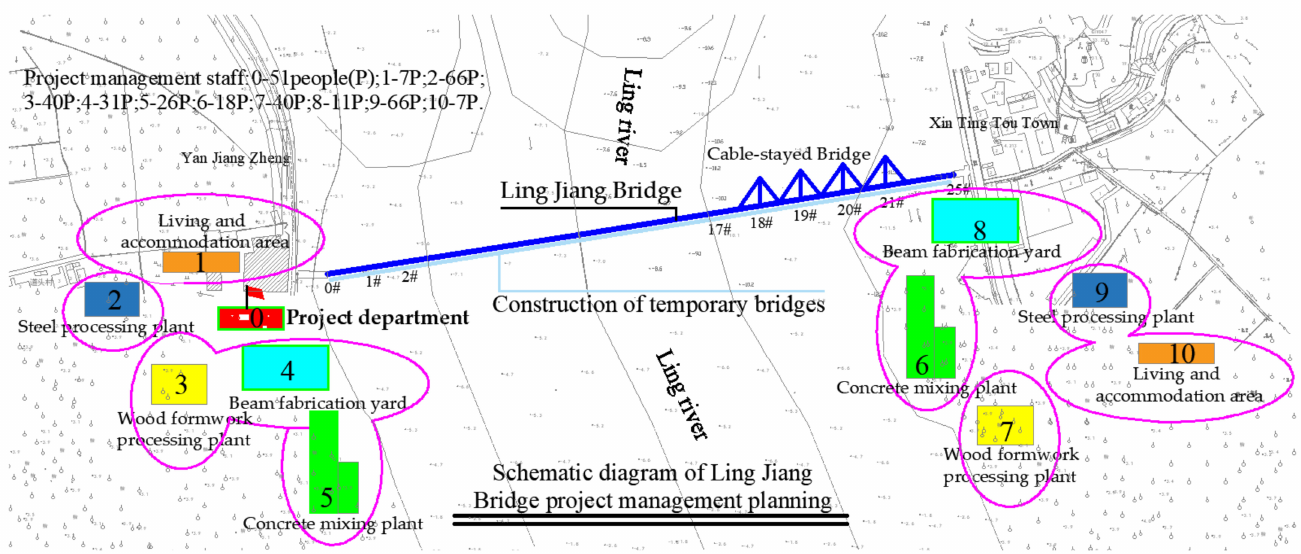
Figure 8. The project management organization’s arrangement of on-site